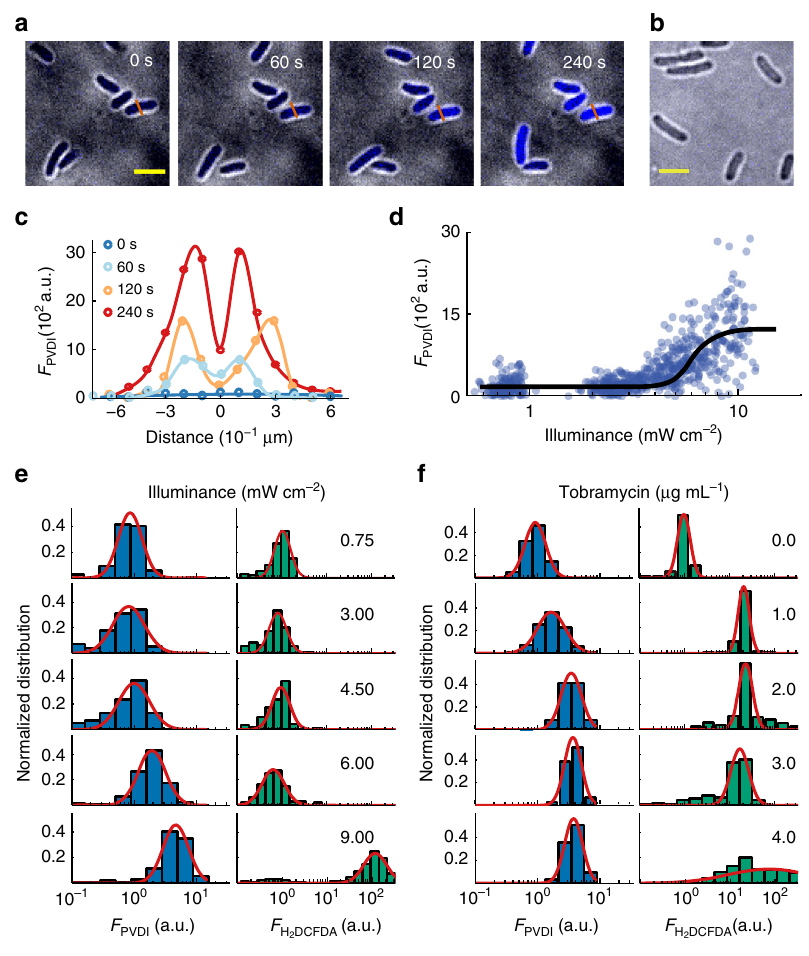
Fig. 1 Environmental stresses trigger the accumulation of a bacterial siderophores in the periplasms of P. aeruginosa . Representative bright- fi eld (gray) + confocal images show that a illuminations of violet-laser (405 nm, 6.00 mWcm (cid:1) 2 ) trigger the accumulation of a bacterial siderophores (pyoverdine, PVDI) in wild-type P. aeruginosa within 4 min and b Δ pvdA cells did not produce PVDI despite illuminations (6.00 mWcm (cid:1) 2 ), where the PVDI is indicated by blue colors. c Distributions of PVDI fl uorescence intensities along the vermillion line across the bacterium shown in a for the time t = 0, 60, 120, 240 s, from bottom to top. d Photon-stress dependence of PVDI fl uorescence intensity in single cells, where cells were exposed to violet-laser for 2 min. The dots and the line present data arising from single bacteria and from the average of multiple bacteria, respectively. e , f Normalized histograms of PVDI (blue bar) fl uorescent intensities or ROS-speci fi c dye H fl uorescent intensities (bluish green bar) arising single cell in the presence of e different photon- 2 DCFDA stresses (0.75, 3.00, 4.50, 6.00, and 9.00 mWcm (cid:1) 2 ) or in addition of f different amount of tobramycin (0.0, 1.0, 2.0, 3.0, and 4.0 µ g mL − 1 ), where cells were exposed to violet-laser for 2 or 8 min or tobramycin for 1 or 7 h, respectively. Scale bar for all images are 2 µ